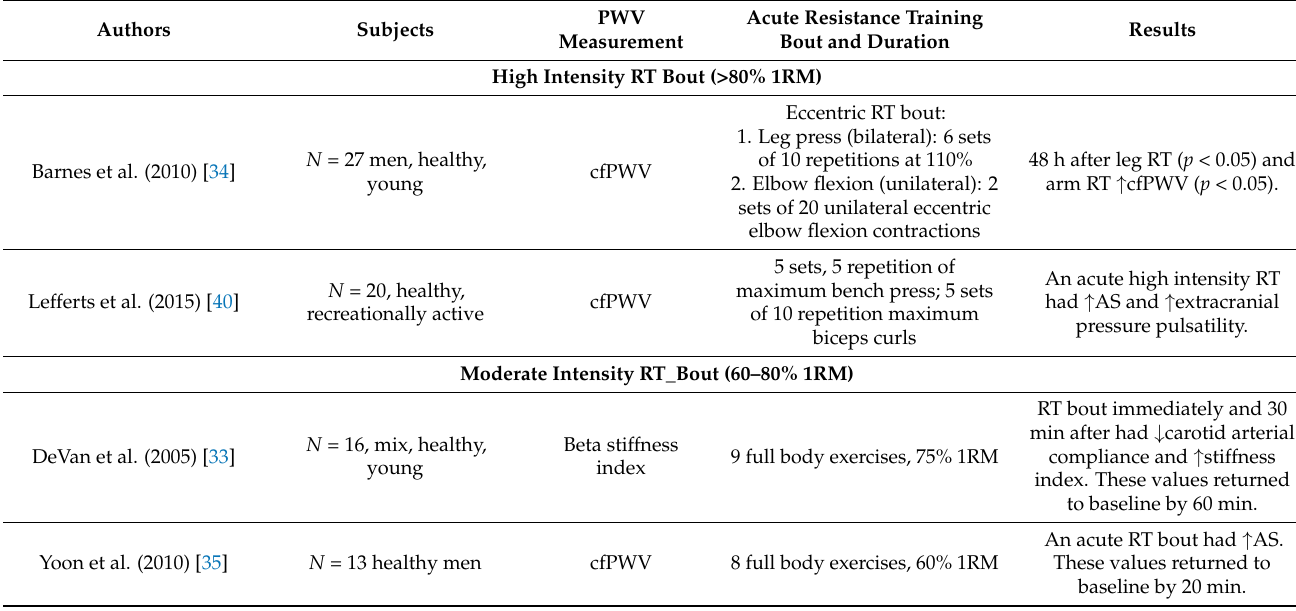
Figure 1. Flowchart of the selection process. Table 1. Changes in arterial stiffness and pulse wave velocity as a result of acute resistance training